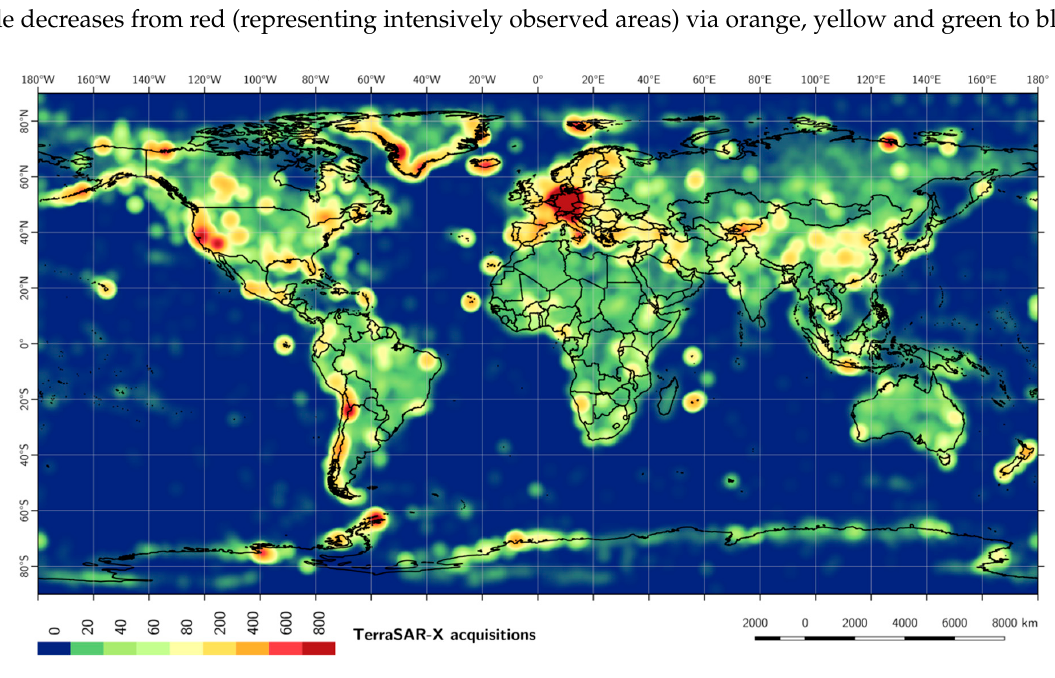
Figure 12. Geographic and quantitative distribution of scientific areas of interest observed by TerraSAR-X between 2007 and 2017, the color indicates the number of acquisitions per 1° × 1° tile. The research sites are globally distributed, with a large concentration on central Europe.